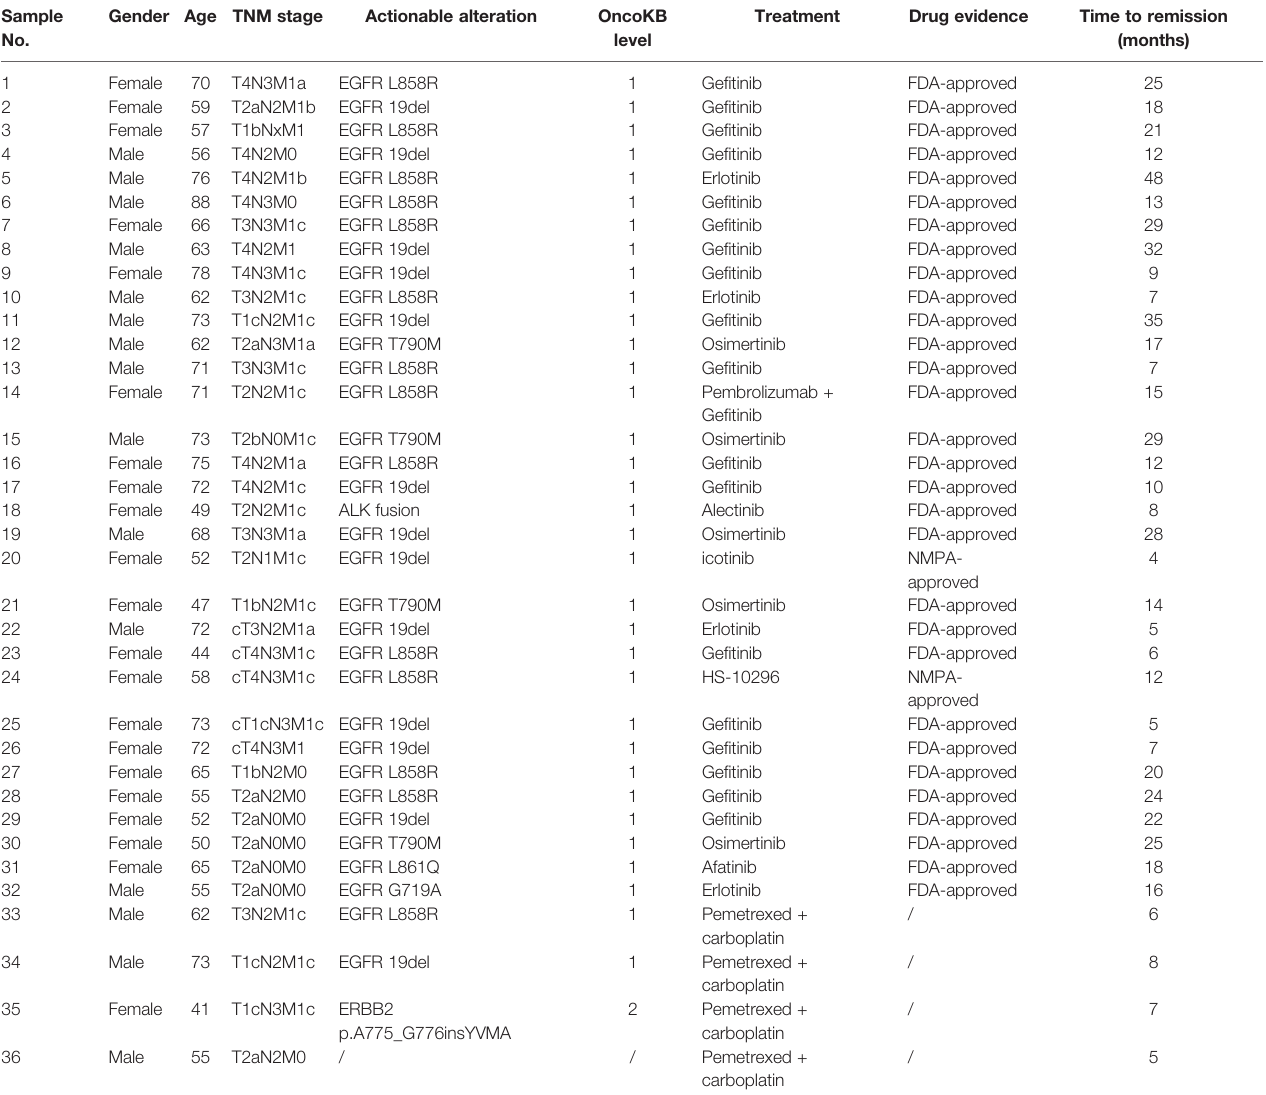
TABLE 2 | Treatment follow-up records. Sample No.